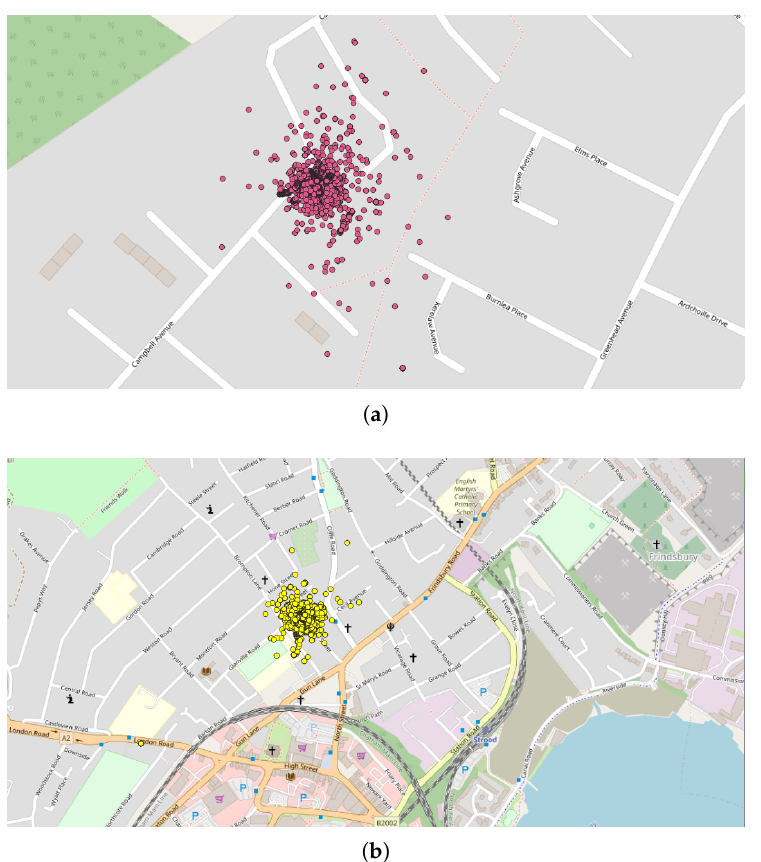
Figure 8. Representation of the clusters found in Stevenston (Scotland, October 2019) and Strood (England, November 2018): ( a ) Stevenston cluster (in pink); represented area of approximately 195 m × 300 m; ( b ) Strood cluster (in yellow); represented area of approximately 0.86 km × 1.70